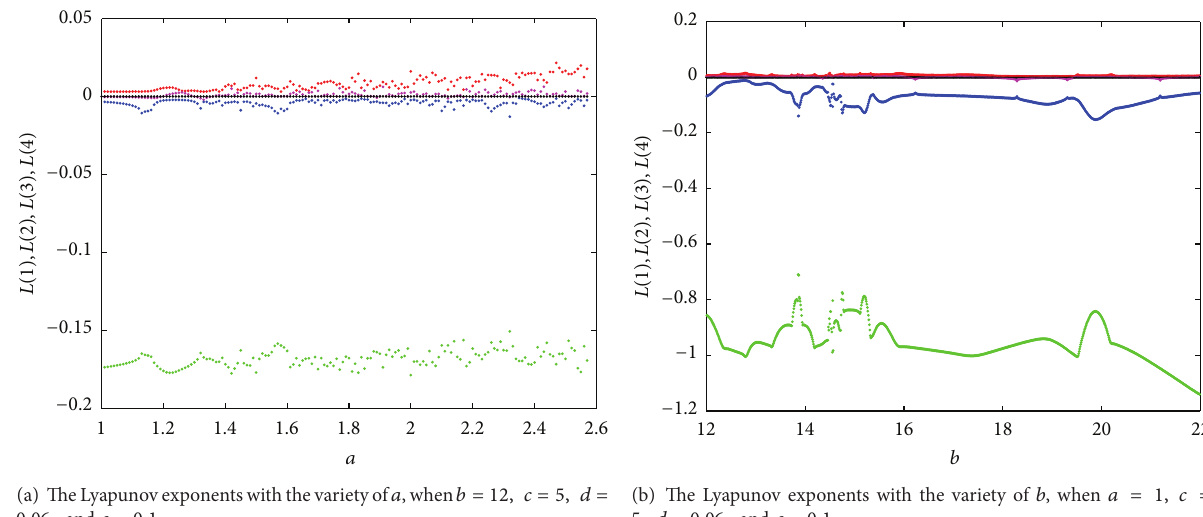
Figure 4: The Lyapunov exponents with the variety of parameters 𝑎(𝑎 ∈ [1,2.6]) and 𝑏(𝑏 ∈ [12, 22]) when the step length is 0.001.